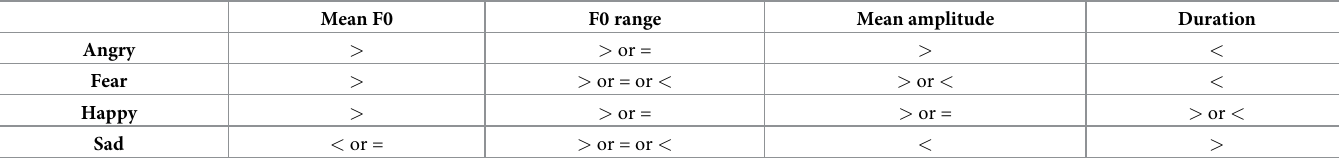
Table 1. Summary of predicted acoustic characteristics of the four emotions relative to the neutral emotion in Experiment 1. The symbols > , < , and = indicate an emotion is associated with a higher, lower, or comparable value compared to the neutral emotion. Mean F0 F0 range Mean amplitude Duration Angry